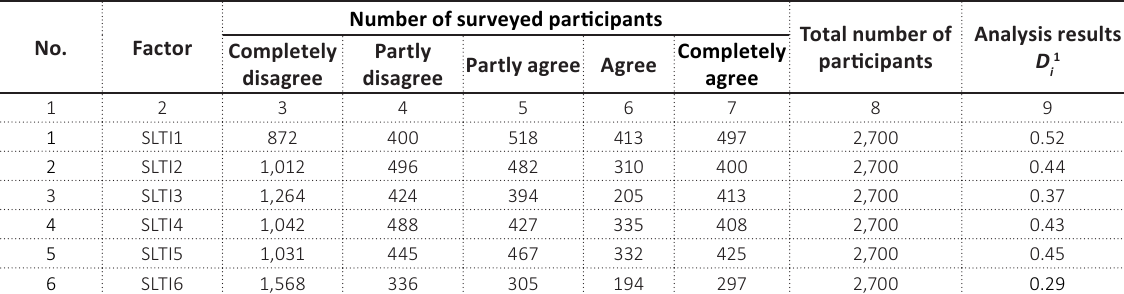
Table 3. Effectiveness of smart learning technology infrastructure